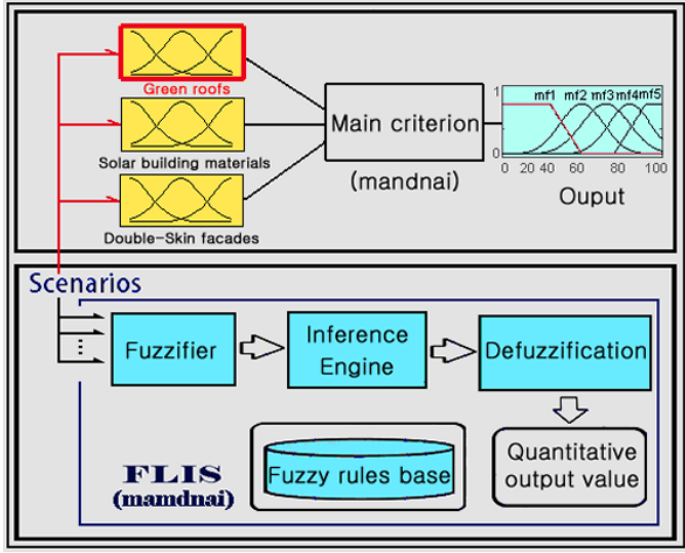
Figure 4. The reasoning and computing of scenarios input into the